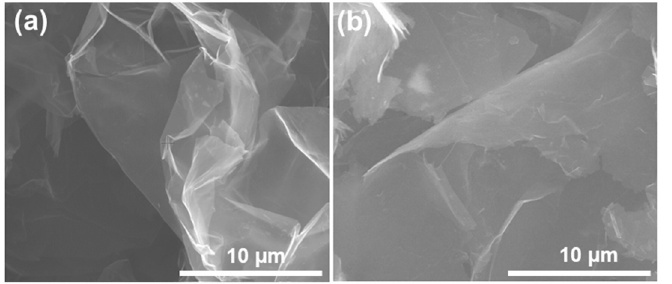
Figure 2. SEM images of the graphene nanoplatelets before ( a ) and after ( b ) modification with the